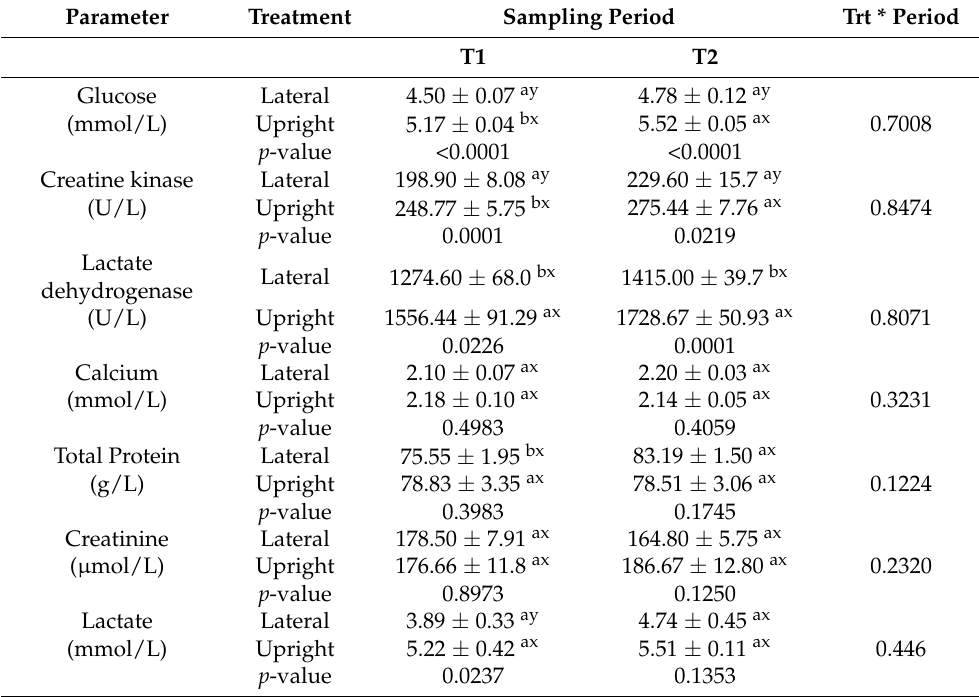
Table 1. Differences in blood biochemical parameters in cattle subjected to different slaughter positions before slaughter (T1), and after neck cut